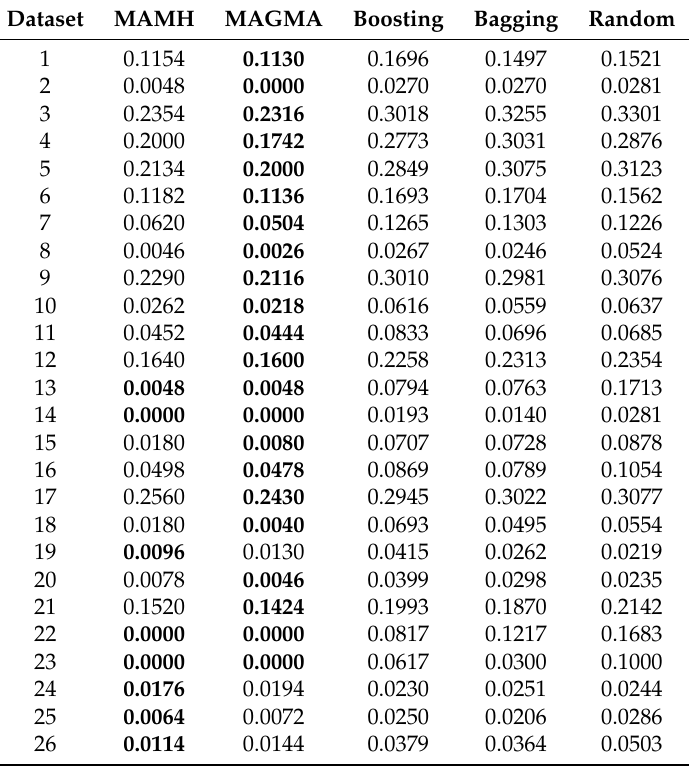
Table 7. The error rate of the hybrid architectures and three traditional ensemble generation